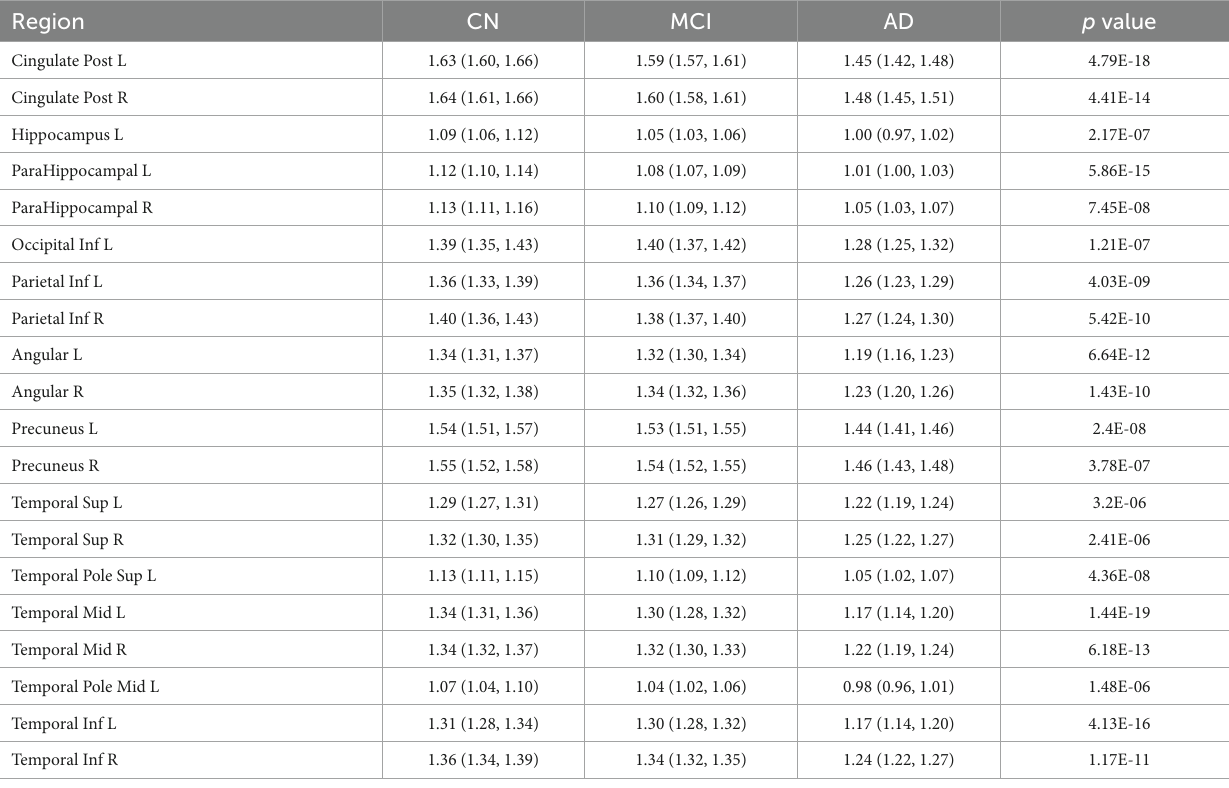
TABLE 2 Brain regions identified to have significantly different glucose metabolism between CN, MCI and AD in the baseline analysis. Region CN MCI AD p